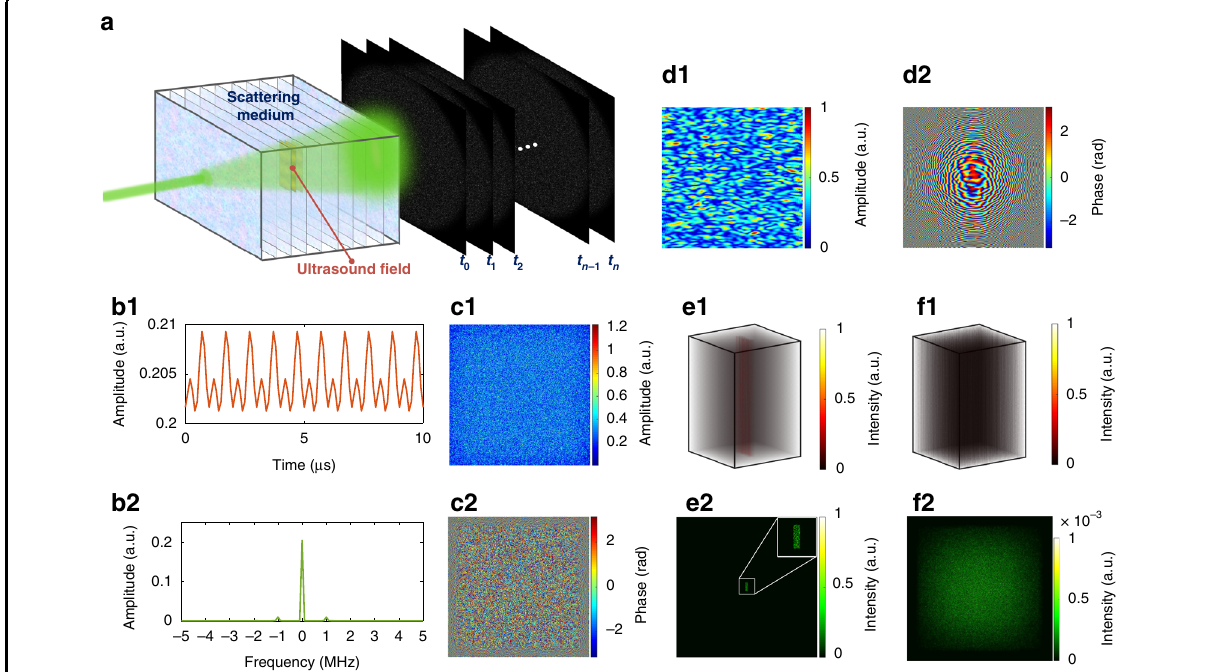
Fig. 2 Conceptual simulations of UFP optical focusing into scattering media. a Schematic of the simulation model. b1 Amplitude time sequence of the optical fi eld at a given pixel of the observation plane when the ultrasound fi eld is ON. b2 , Fourier transform amplitude of the time sequence in b1 . c1 – c2 Amplitude and phase maps, respectively, of the frequency-unshifted optical fi eld in the observation plane when the ultrasound is ON. d1 – d2 Amplitude and phase maps, respectively, of the complex differential fi eld between the frequency-unshifted photons when the ultrasound is on the ON and OFF states. The amplitude map is normalized here. e1 A 3D representation of the time-reversed optical intensity in the scattering medium, using UFP optical focusing. The intensity is normalized. e2 Time-reversed optical focus inside the scattering medium. Inset, the zoomed-in view of the focus. f1 A 3D representation of the optical intensity in the scattering medium when playing back a random optical wavefront. The intensity is normalized to the maximum intensity of the time-reversed optical focus in e1 . f2 Only speckles can be seen at the focal position of the ultrasound when playing back a random optical